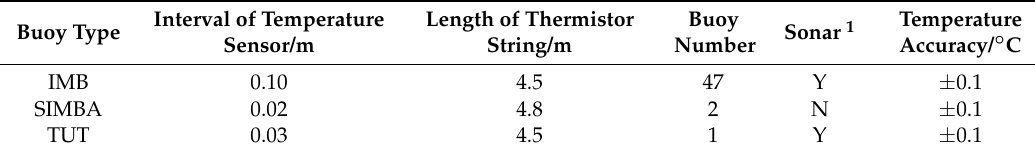
Figure 1. ( a ) The initial deployment positions of 47 IMB buoys (red dots) and one TUT buoy (green dot) in the Arctic from 2002 to 2016. ( b ) The initial deployment positions of two SIMBA buoys near Zhongshan Station, Antarctica in 2013 and 2014. Table 1. Critical parameters of ice-tethered buoys.